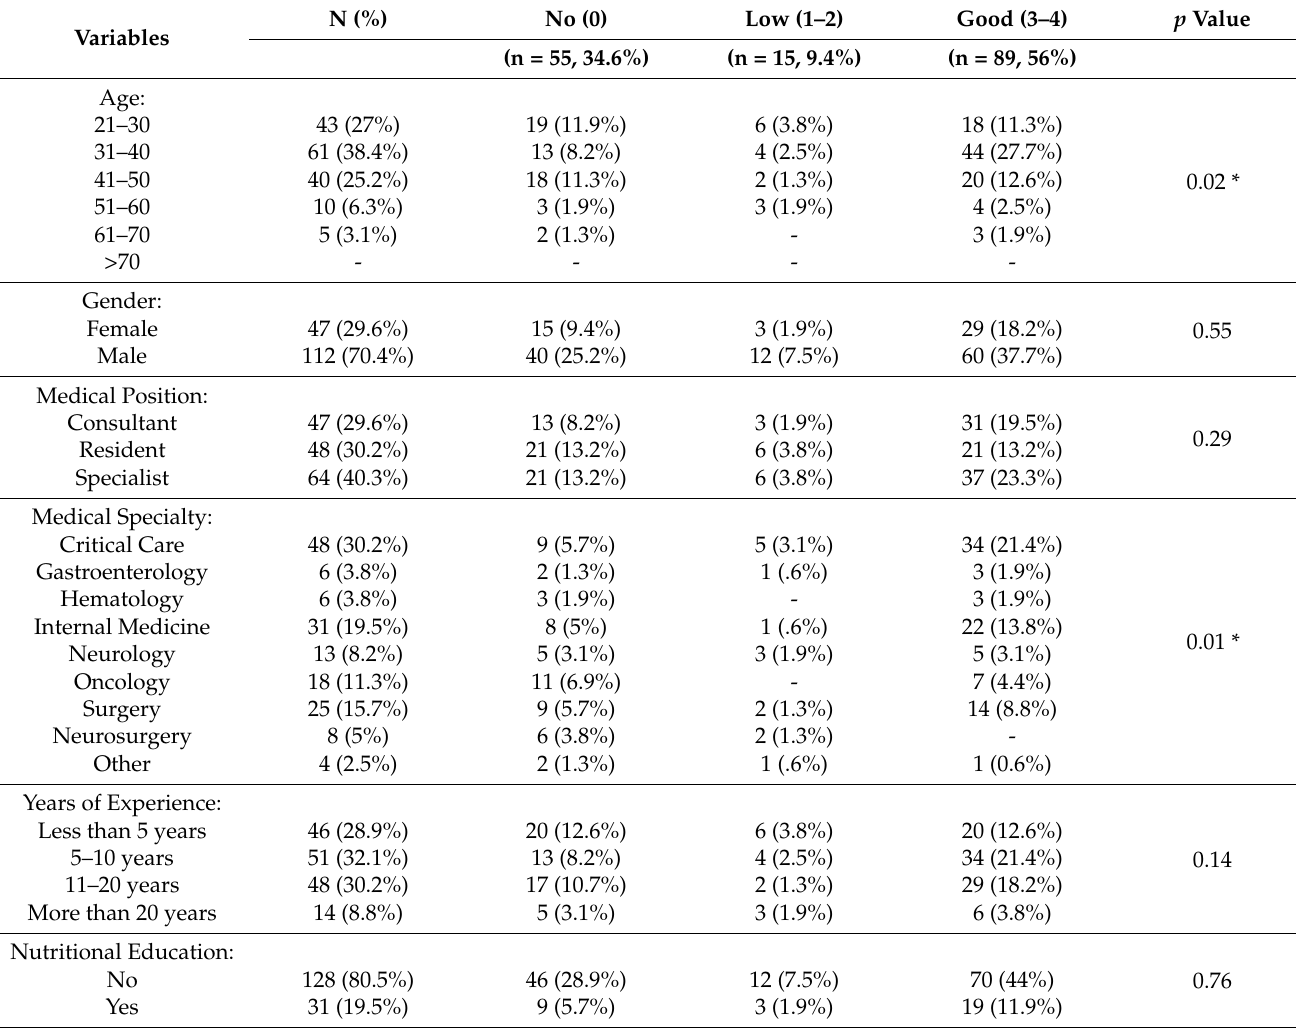
Table 1. Characteristics of the survey participants and the knowledge of RFS (n =